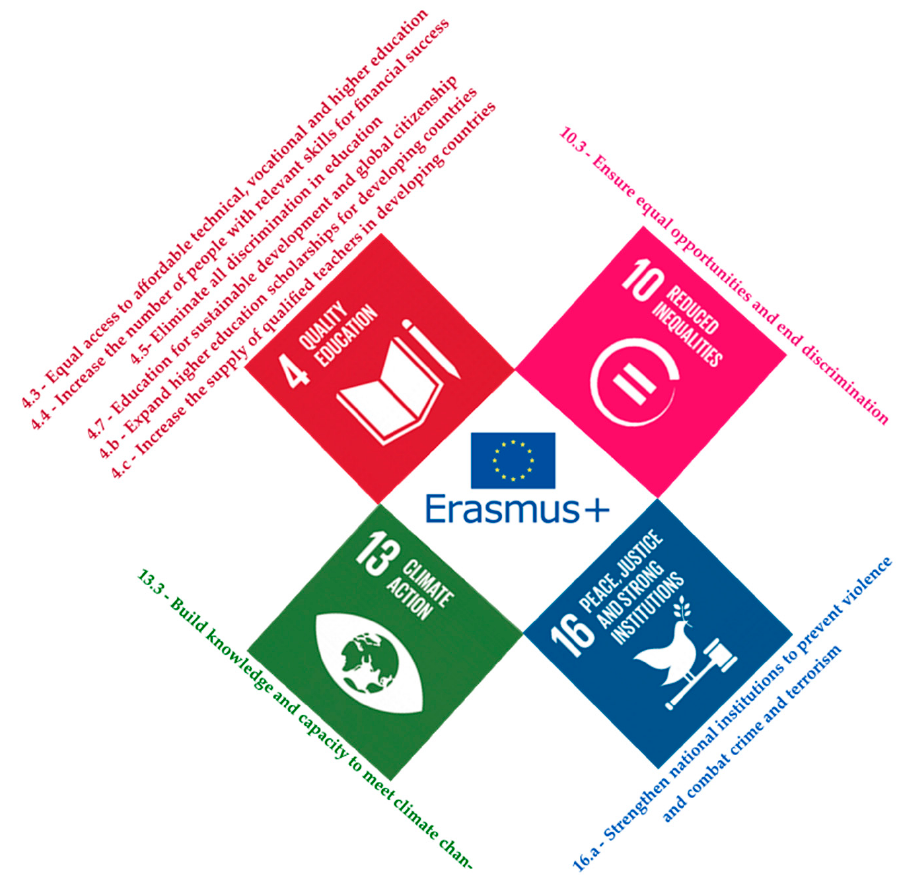
Figure 2. Erasmus+ contributions to Sustainable Development Goals. Source: own elaboration based on https://sdg-tracker.org/ (accessed on 14 February 2023).